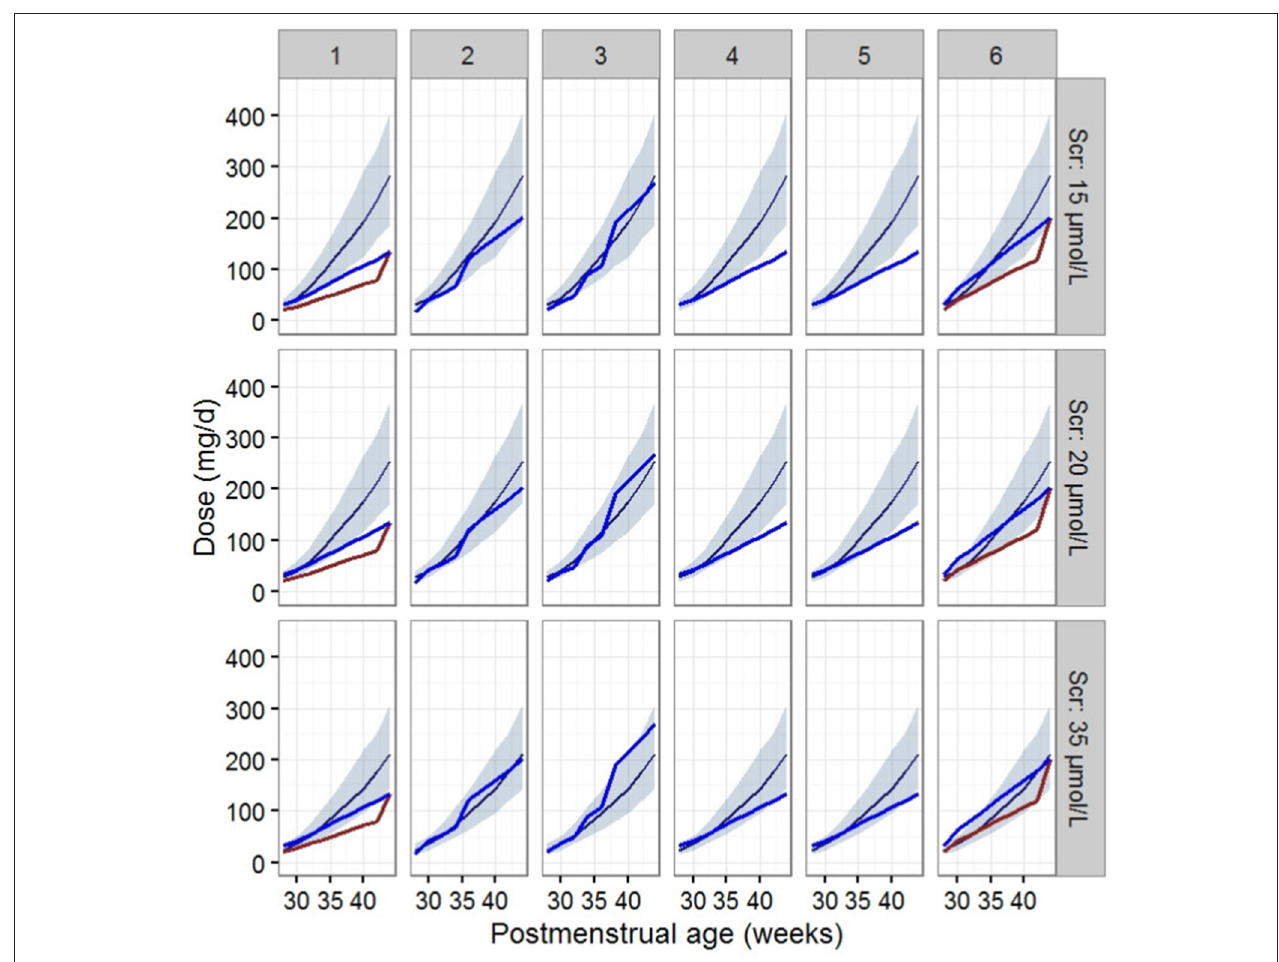
FIGURE 3 | Vancomycin dosage regimen recommended by the six guidelines relative to the regimen recommended by our final model in typical patients when AUC 24h /MIC ≥ 400. The six guides correspond to (1) the FDA labeled dosage (2017), (2) the British National Formulary (2016–2017) and the Blue Book (2016), (3) the Neonatal Formulary (2015), (4) the Red Book (2015), (5) the Pediatric and Neonatal Dosage Handbook (2015-2016), and (6) Neofax (2017). The red and blue lines in (1) and (6) refer to dosage guidelines for patients with a PNA of 7 days and 15 days respectively. The blue lines in (2),(3),(4), and (5) refers to dosage for PNA of both 7 and 15 days. The dark blue smooth curve represents the mean dosage for the present study, and the light blue ribbon corresponds to the 15–85% dosage interval.